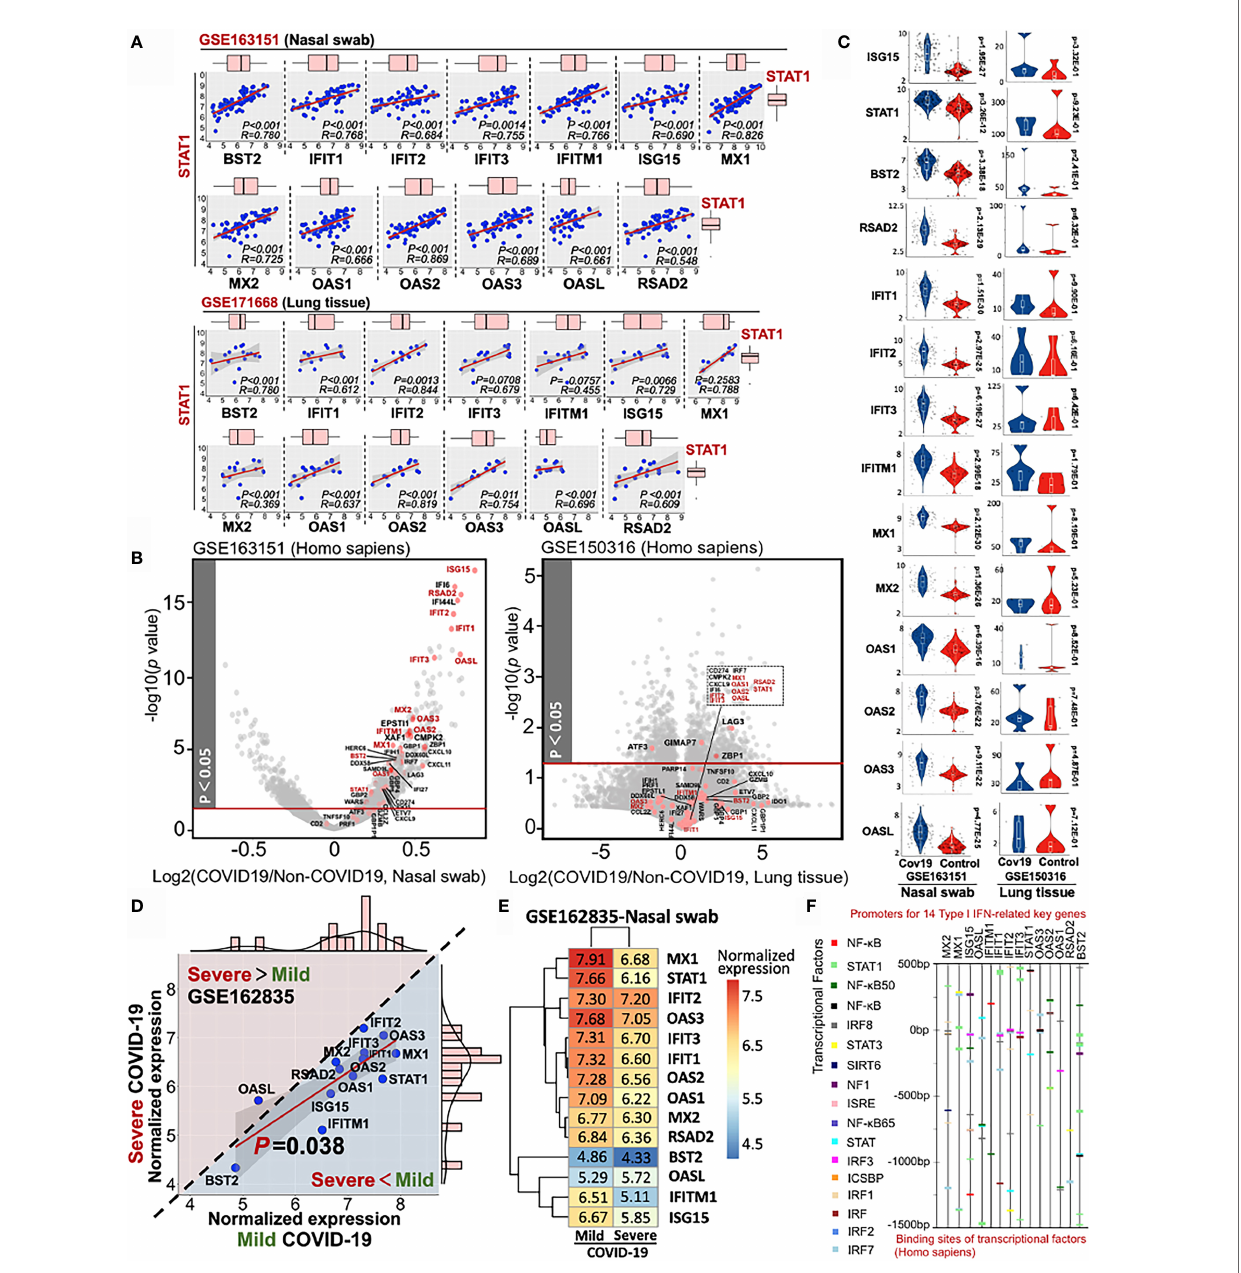
FIGURE 5 | Strati fi ed diagnose of COVID-19 severity in term s of 14 Type-I interferon-inducible genes. (A) Linear relationship between STAT1 and other 13 IFN- related genes. (B) Volcano plots of differential gene pro fi le in GSE163151 (nasal swab) and GSE150316 (lung tissue) (COVID-19 vs non-COVID-19). Red points shown in the volcano plots stand for the intersective genes across nasal swab and lung tissue. (C) Differential transcriptional expression of 14 IFN-I-related genes with or without SARS-CoV-2 infection (D) Comparative analysis of the 14-gene transcriptional pro fi le (GSE162835) between mild and severe COVID-19. A diagonal line divides two different expression trends. The upper panel (pink background) indicates the positive correlation between disease severity and gene expression, while the negative correlation (blue background) is shown in the lower panel. (E) A heatmap showing the values of normalized expression of 14 genes in either mild or severe COVID-19. (F) Potential transcriptional factors binding to the promoter sits of 14 key genes analyzed by Interferome